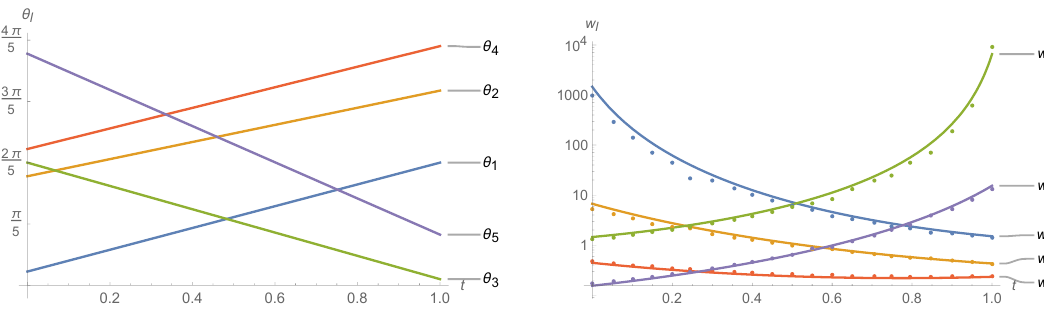
Figure 5 . The θ -parameters and the normalized Wilson loop expectation values on the curve (5.5). The dots represent the data obtained by numerically solving the integral equations with λ = 1000